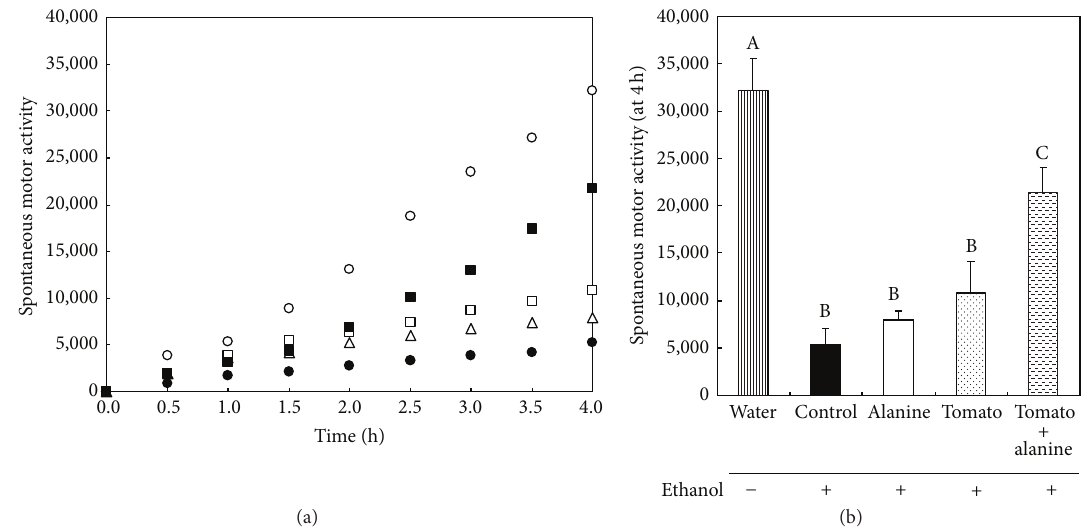
Figure 1: (a) The effects of a combination of tomato juice and alanine on the spontaneous motor activity 4h following the ingestion of 4.0 g/kg of ethanol (Experiment 1). The rats were orally given 20 mL/kg of tomato juice (tomato group), 5.0% aqueous alanine (alanine group), tomato juice with 5.0% alanine (tomato + alanine group), or water (water and control group). Results are expressed as the mean values. I , water (ethanol-free); e , control; △ , alanine; ◻ , tomato; ◼ , tomato + alanine. (b) The spontaneous motor activity at 4h following the ingestion of 4.0 g/kg of ethanol. Results are expressed as the mean and standard deviations ( 𝑛 = 4 ). Mean values with different uppercase letters differ significantly (ANOVA, post hoc Tukey’s HSD test, 𝑝 < 0.05 ) among five